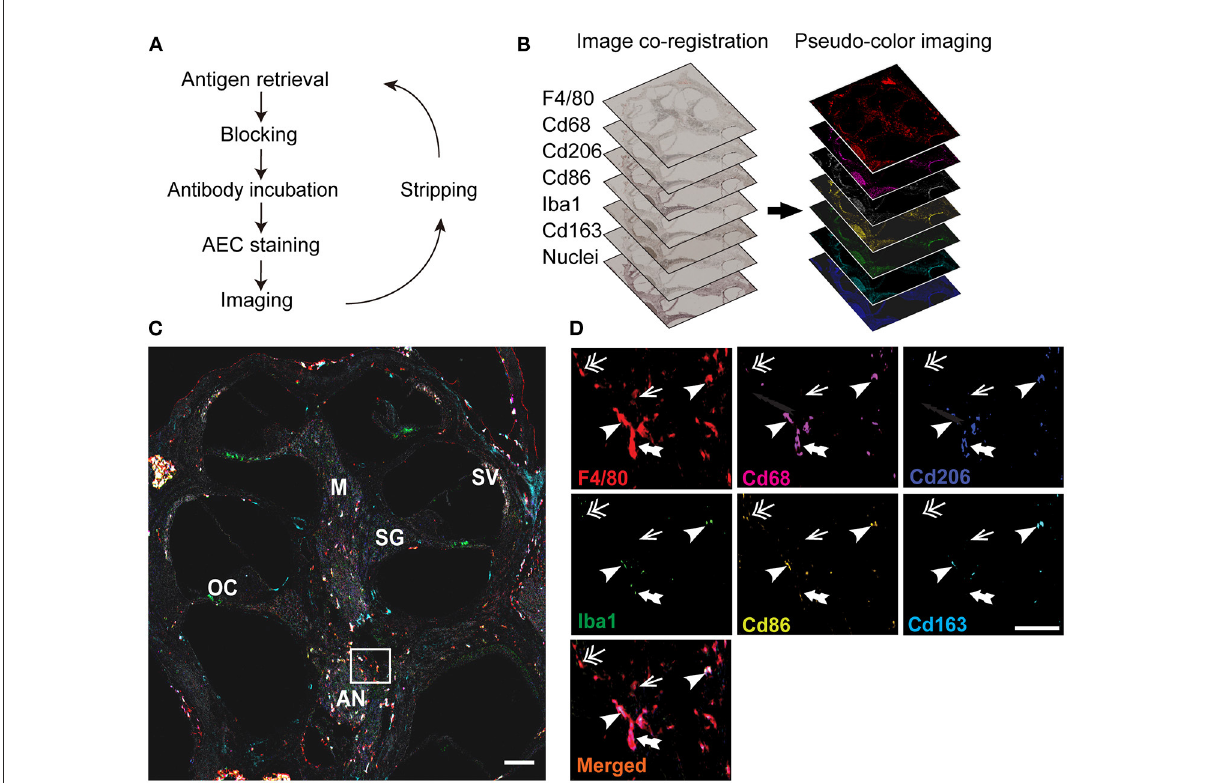
FIGURE1 Overview of image processing for multiplex immunohistochemistry (mIHC) of the cochlea. (A) Schematic view of the mIHC. The cochlea of 4–6 weeks old mice were harvested, fixed with 4% paraformaldehyde, decalcified, and embedded in paraffin. Sections were deparaffinized and immunostained with a primary antibody and visualized by using chromogenic staining (AEC; 3-amino-9-ethyl-carbazole). After imaging with a whole slide scanner, the antibody and chromogenic stains were stripped out with a serial gradient of ethyl alcohol until the signals disappeared entirely. The staining and stripping steps were repeated for six different macrophage markers (F4/80, CD68, CD206, CD86, Iba1, and CD163) and hematoxylin. (B) Image processing. The images were co-registered to align the same area in each slide, and the images were converted into pseudo-colored single-marker images to identify the positive signals of each marker. (C) Merged image of all the markers. Individual images were merged into one image showing the expression of all the markers, and analyzed to identify the markers expressed in each F4/80 + macrophage. Different areas of the cochlea were examined to identify the macrophage diversity. SG: spiral ganglia, SV: stria vascularis, M: modiolus, OC: organ of Corti, AN: auditory nerve. (D) Magnified area showing the markers expressed by the macrophages in the inner ear. Some macrophages expressed only one marker F4/80 (arrow), whereas others expressed four (double-head arrow), five (double-tail arrow), and even all the markers (arrowhead). Scale bar: the whole cochlea, 500 µ m; magnified region, 30 µ m.